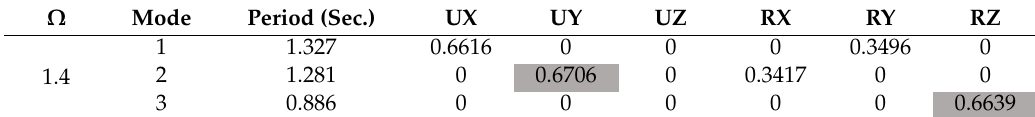
Table 5. Modal Participating Mass Ratio Buildings (with b / r = 3.16, 1 < Ty < 2 s, Ω = 1.4).